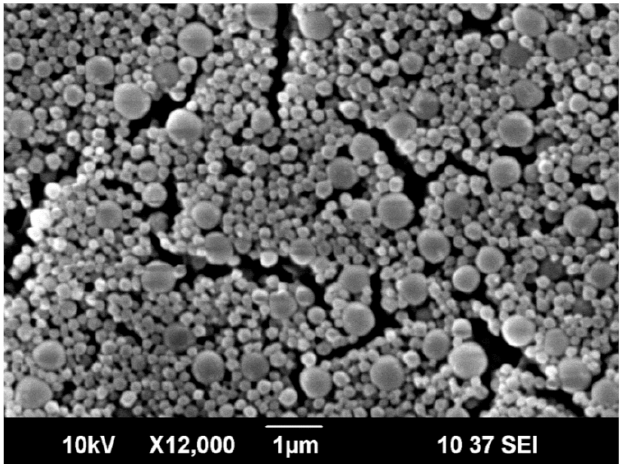
Figure 2. SEM image of 3-(Trihydroxysilyl)propyl methacrylate (TPM) submicrocapsules (SMCs) when silica / TPM weight ratio was